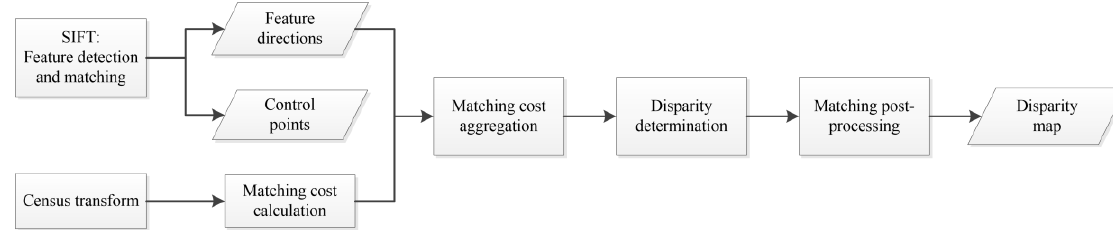
Figure 2. Processing steps for disparity estimation using the integrating SIFT and SGM